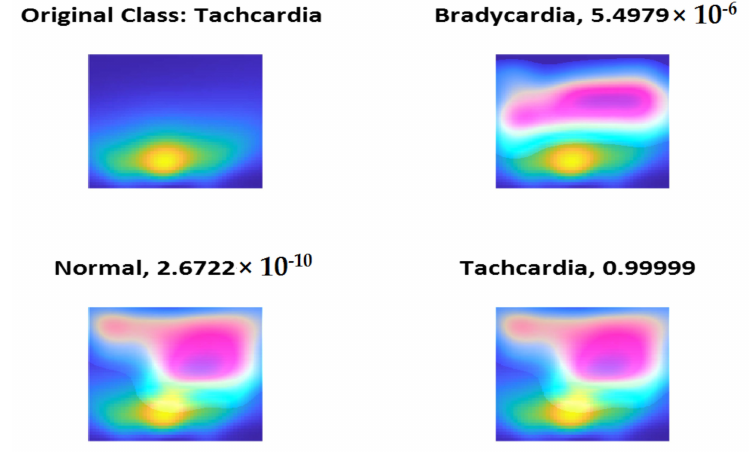
Figure 16. Tachycardia Class CAM using ShuffleNet and Scalogram.